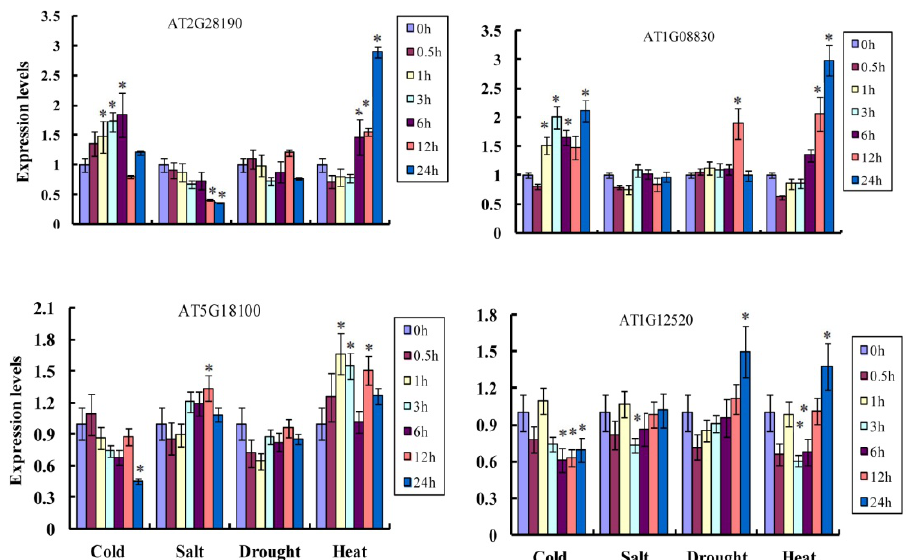
Figure 7. The expression pattern of Cu/Zn SOD genes in Arabidopsis thaliana under different types of stresses, including cold, heat, salt, and drought. Statistically significant differences are indicated p < 0.05 by star (*) (Student’s t -test).